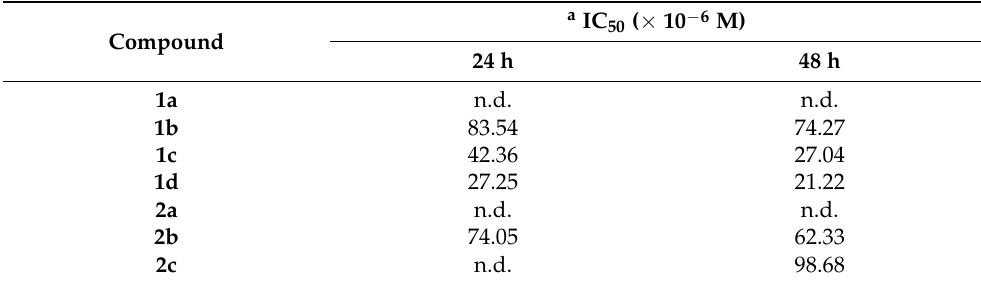
Table 1. IC 50 values of tacrine-coumarin hybrid molecules 1a–2c in A549 cancer cell lines.